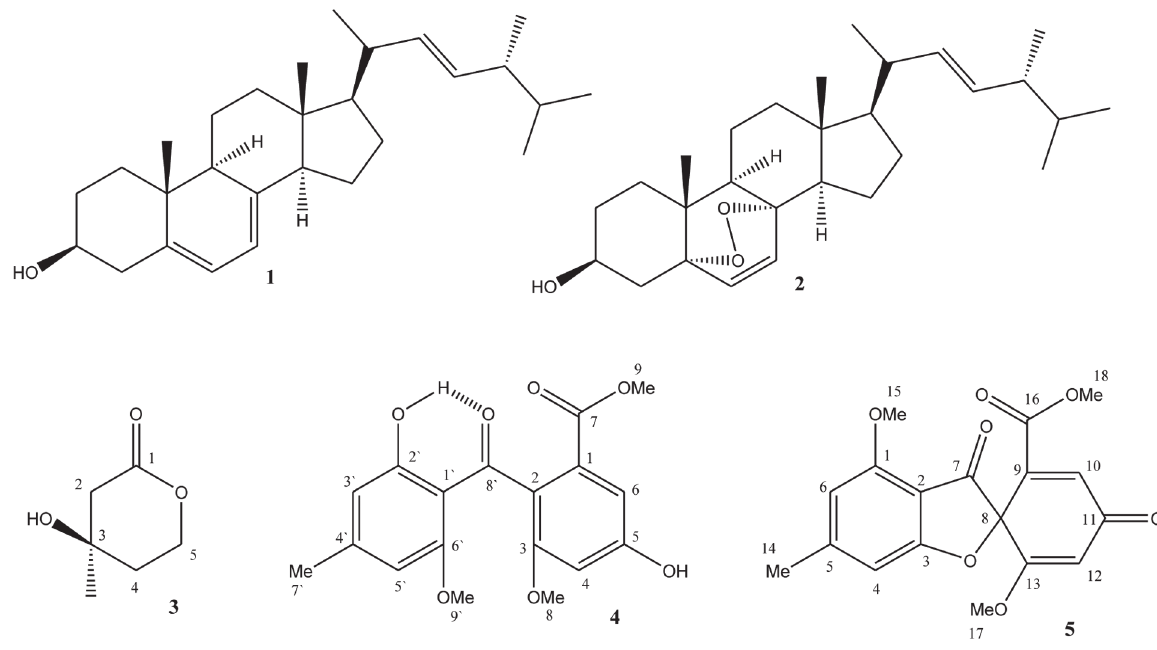
Figure 1 - compounds isolated from Aspergillus sp